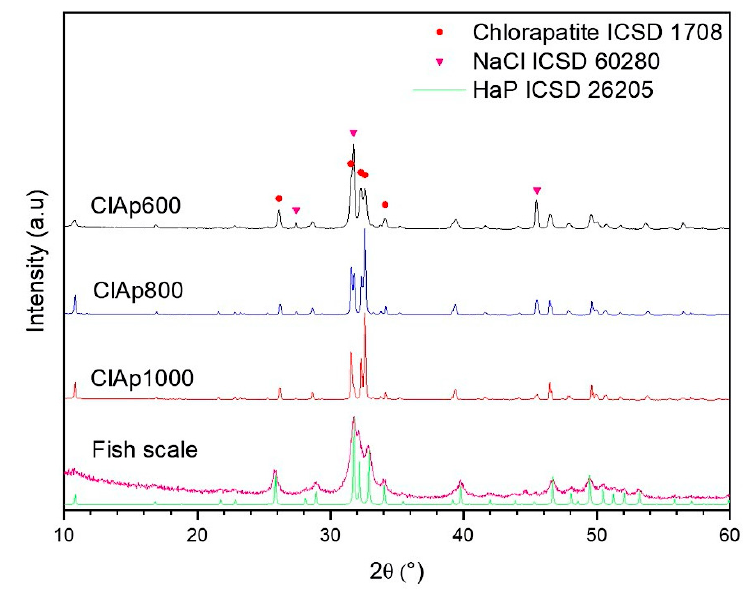
Figure 3. XRD patterns of the chlorapatite syntheses as a function of calcination temperature.